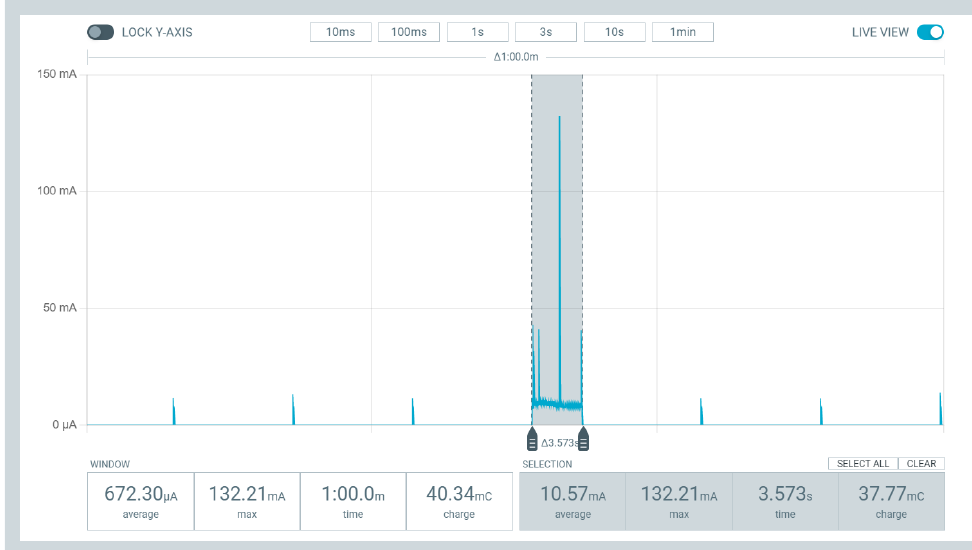
Figure 4. Example of sensor modules’